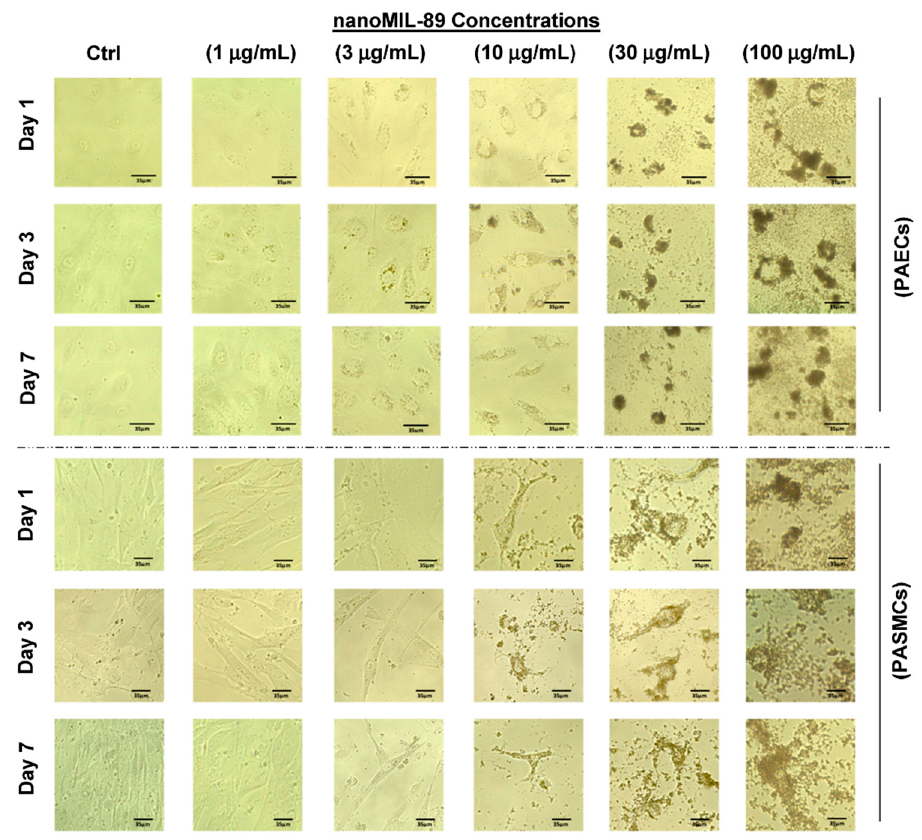
Figure 4. nanoMIL-89 uptake by PAECs and PASMCs. Cells were treated with different nanoMIL-89 concentrations (0, 1, 3, 10, 30 and 100 µg/mL). Images were taken using an inverted light microscope (magnification 20×) at days 1, 3 and 7.